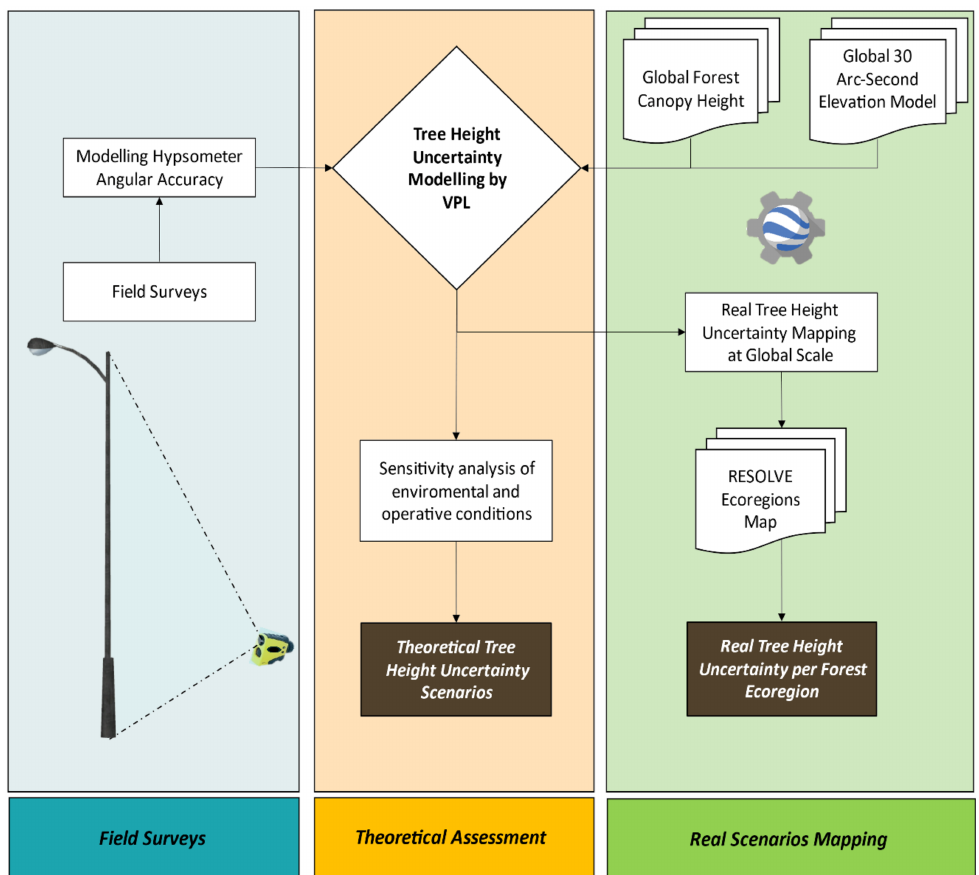
Figure 1. Workflow adopted. Starting from field surveys, the hypsometer accuracy was modelled. Theoretical evaluations were performed concerning the formalization of tree height uncertainty model. Subsequently, a sensitivity analysis and theoretical scenarios were provided. Finally, globally available data in GEE was used to explore real tree height uncertainty for each forest